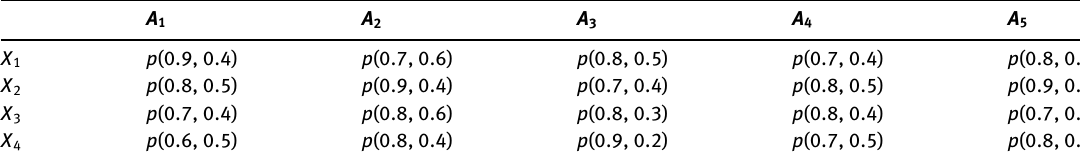
Table 7: Pythagorean Fuzzy Decision by Decision Maker d 4